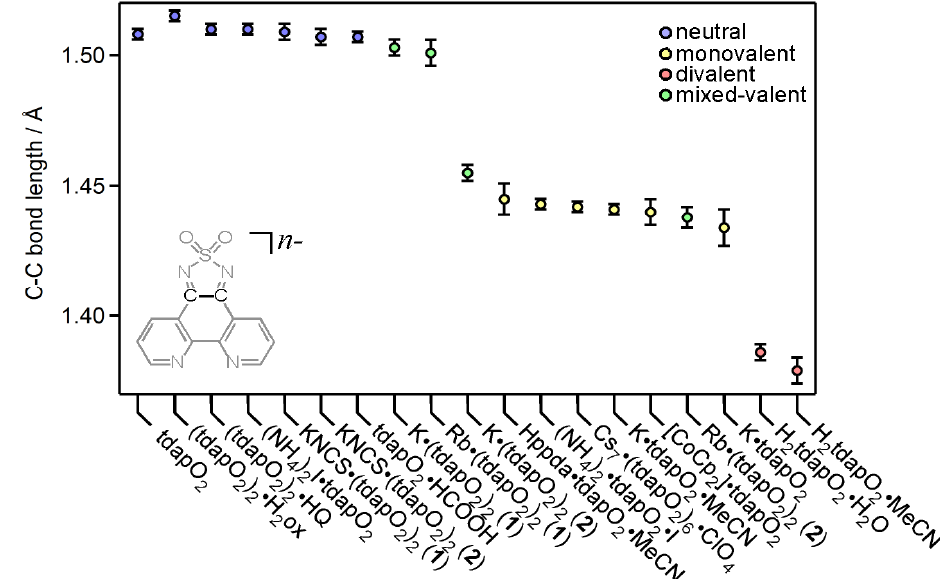
Figure 17. Crystal structure of K•tdapO dependence of χ